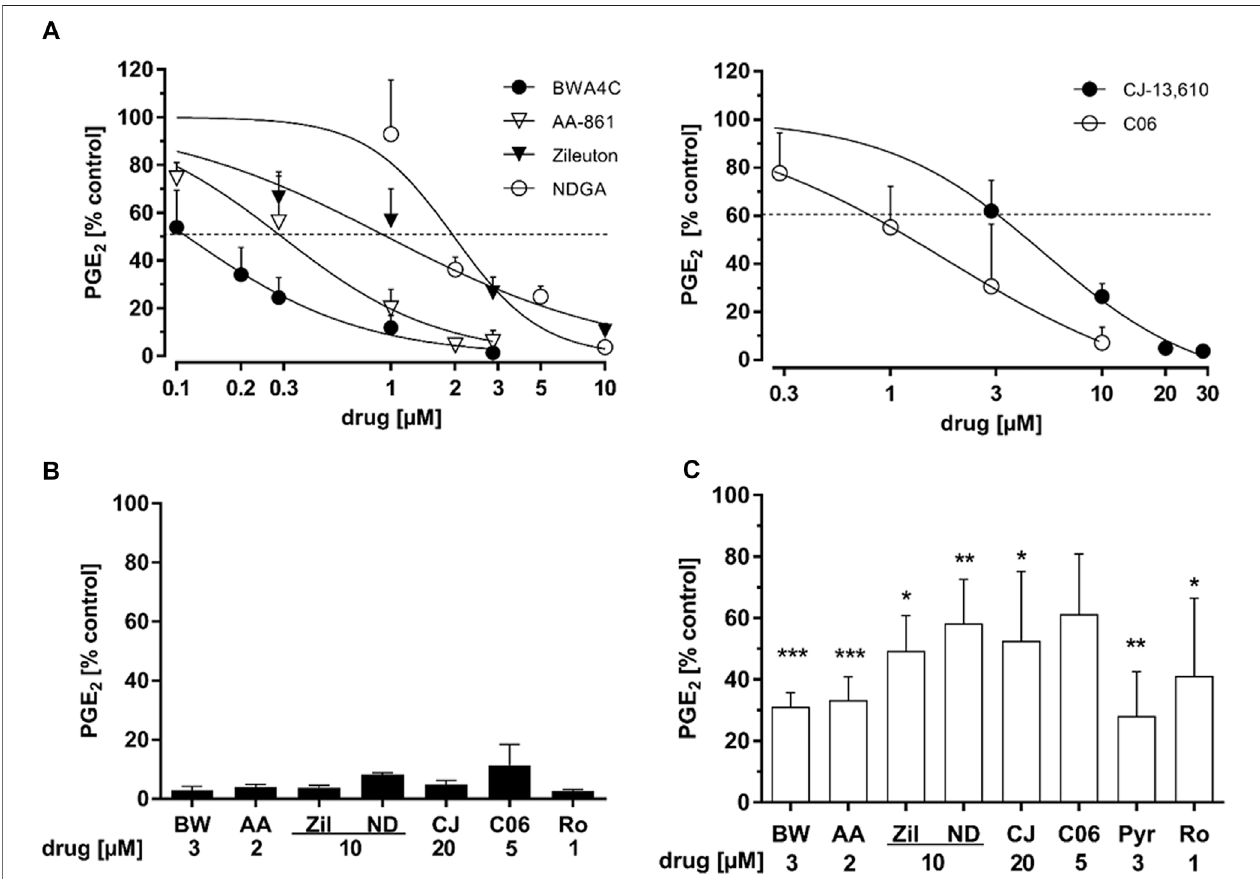
FIGURE 2 | Inhibition of prostaglandin E 2 levels in HeLa, A549 and HCA-7 cell supernatants. (A) HeLa cells were treated with cytokines (IL-1 β 1 ng mL − 1 , TNF α 5 ng mL − 1 ) plus increasing concentrations of the 5-LO inhibitors AA-861, BWA4C, NDGA, zileuton, CJ-13,610 or C06 for 16 h (B) A549 cells were treated with IL-1 β (1 ng mL − 1 ) and the 5-LO inhibitors for24 h (C) HCA-7 cells were treated withthe 5-LO inhibitors for 4 h. PGconcentrations in thecells supernatants wereassessed by LC-MS/MS. 1 µM rofecoxib and 3 μ M Pyr were used as positive controls for COX-2 and cPLA 2 α inhibition, respectively. For detailed methodical descriptions, see the Materials and Methods section. Mean PG release into HeLa cell supernatants: PGE 2 22.6 ± 11.99 ng mL − 1 ; A549 cells: PGE 2 12.53 ± 2.04 ng mL − 1 ; HCA-7 cells: